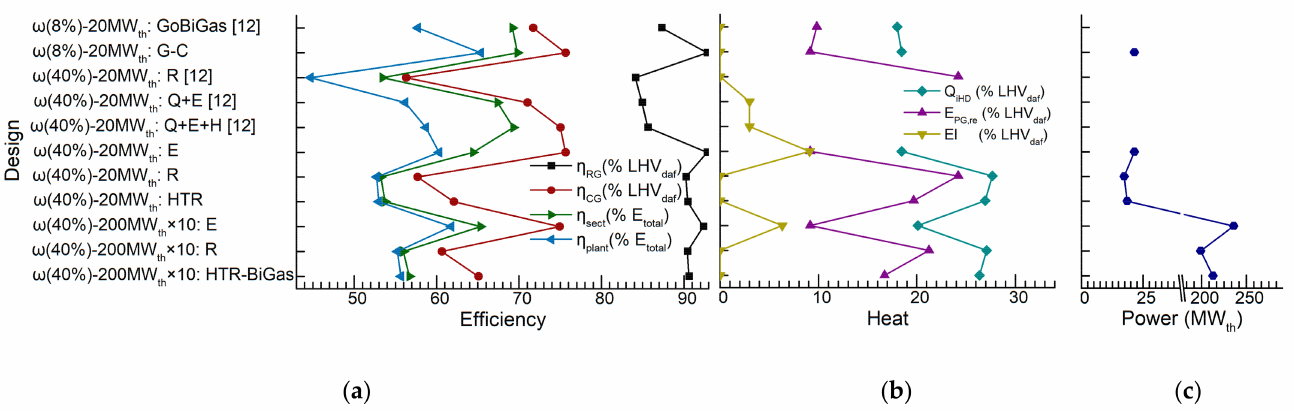
Figure A1. Efficiencies, heats and powers of product gas of GoBiGas, HTR-BiGas and related designs. ( a ) Efficiency; ( b ) heat; ( c ) power of final product gas of a biomass gasification module. ω : moisture content of biomass; GoBiGas: Gothenburg biomass gasification; G-C: co-generation design whose biomass gasification unit is the same as that of GoBiGas; H: heating inlet steam and air; Q: decreasing heat losses of combustor and gasifier; E: electric auxiliary heating; R: increasing recirculated product gas; HTR: heating inlet steam by HTR; HTR-BiGas: high-temperature gas-cooled reactor biomass gasification; η RG : raw gas (RG) efficiency; η CG : cold gas (CG) efficiency; η sect : gasification section efficiency; η plant : plant efficiency; LHV daf : lower heating value of dry ash-free biomass; Q iHD : internal heat demand of gasifier; E PG . re : energy of recirculated product gas; El : auxiliary electricity supply to